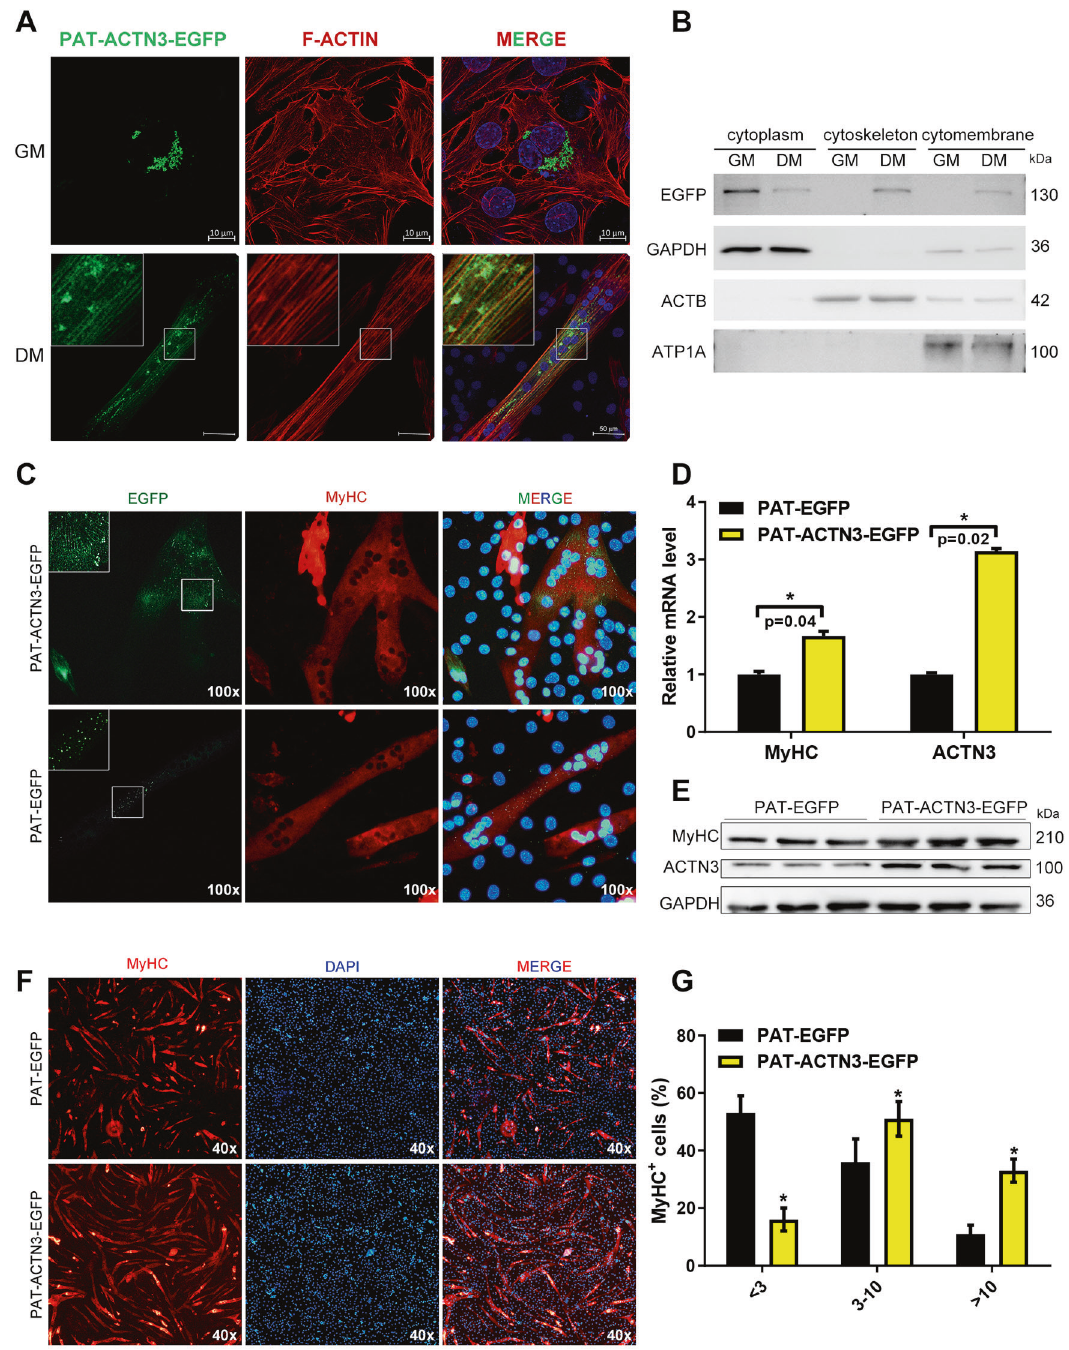
Fig. 7 LDs modulate micro fi lament remodeling during C2C12 differentiation. A The co-localization of PAT-ACTN3-EGFP and micro fi laments in myoblast and myotubes. B The subcellular components were isolated from myoblast and myotubes expressing PAT-ACTN3-EGFP or PAT- EGFP. The protein levels of EGFP were detected by Western blotting. C The localization of PAT-ACTN3-EGFP and PAT-EGFP (control) in MyHC + cells. D The mRNA levels of MyHC and ACTN3 were detected by qPCR in cells expressing PAT-ACTN3-EGFP or PAT-EGFP. E The protein levels of MyHC and ACTN3 were detected by Western blot in cells expressing PAT-ACTN3-EGFP or PAT-EGFP. F The immuno fl uorescence detection of MyHC in cells expressing PAT-ACTN3-EGFP or PAT-EGFP. G The number of nuclei in MyHC + cells. GAPDH was utilized as the cytoplasm reference protein, ACTB was utilized as the micro fi lament reference protein, and ATP1A was utilized as the cytomembrane reference protein. * p < 0.05. Results are from three technical repeats ( N = 3) for a representative of three biological repeats ( N = 3). LDs. In addition, the actinins on LDs surface can transfer to them, septin-9 can bind to Ptdlns5P on the surface of LDs and micro fi lament during micro fi lament remodeling. simultaneously bind to microtubules, which can promote the We utilized ACTN3 as the research object here to analyze the contact between LDs and microtubes and the growth and mechanism of LDs regulating cytoskeletons. ACTN3, as a member aggregation of LDs [18]. Our study has validated the existence of the ACTN family (ACTN1, ACTN2, ACTN3, and ACTN4), can fi x of multiple micro fi lament and microtubule-associated proteins on Cell Death and Disease (2021)